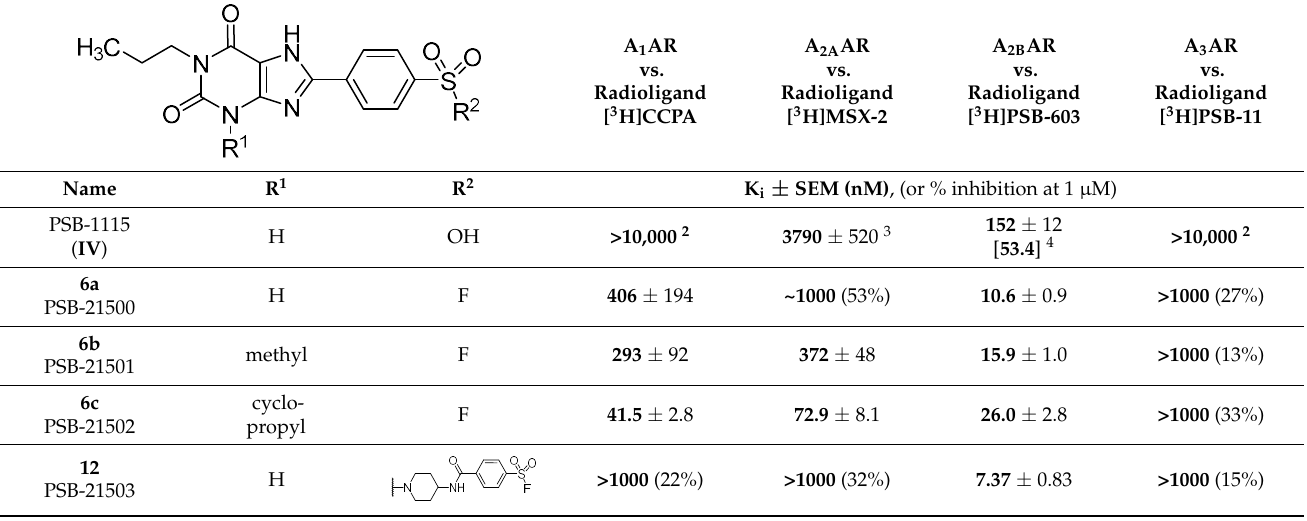
Table 1. (Apparent) affinities of new xanthine derivatives at human adenosine receptors 1 .